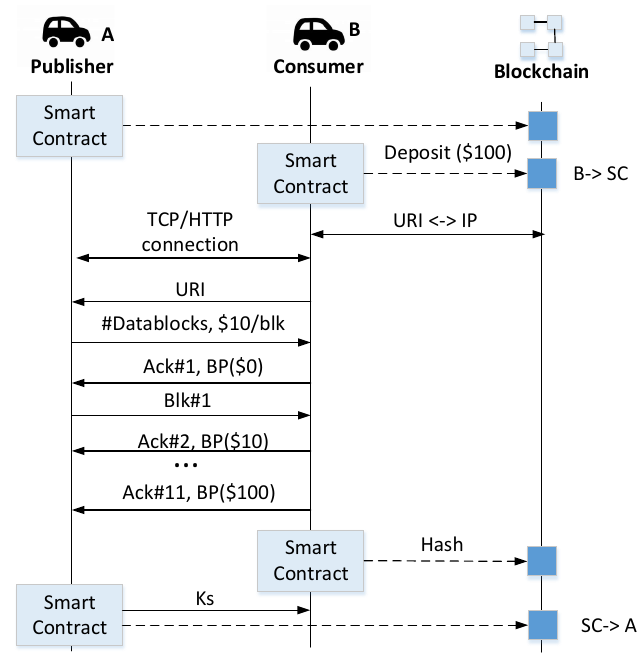
Figure 5. Vehicular content trading procedure based on a smart